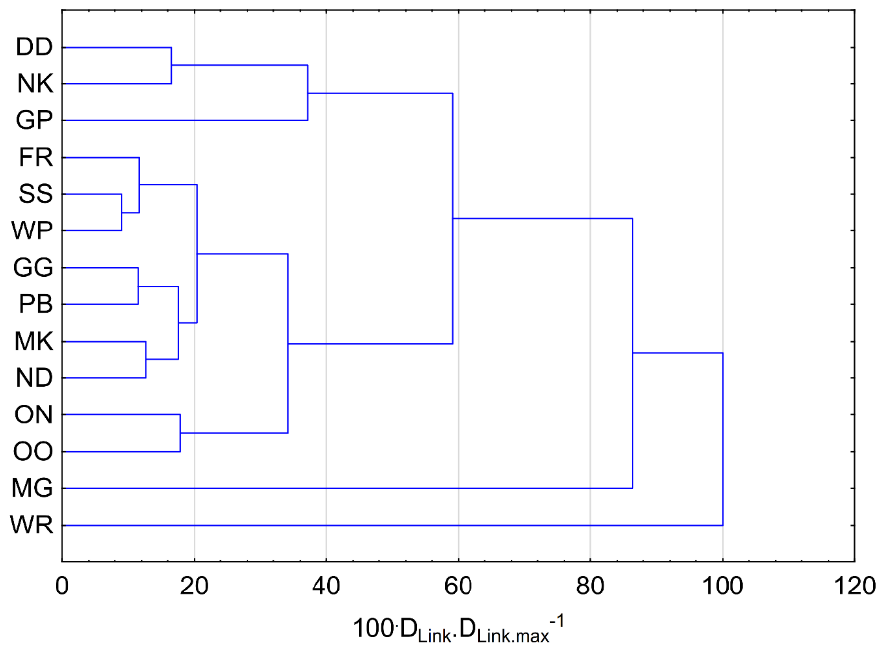
Figure 4. CA results based on indicators of flow changes for 1951–2020.